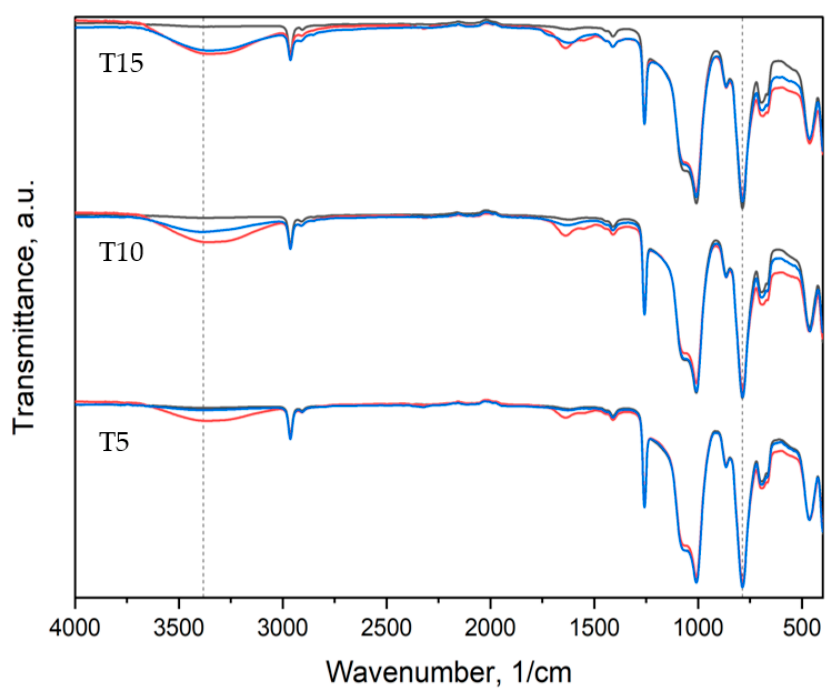
Figure 12. IR spectra of thyme composites: black—before aging, red—2 days of aging, blue—60 days of aging.